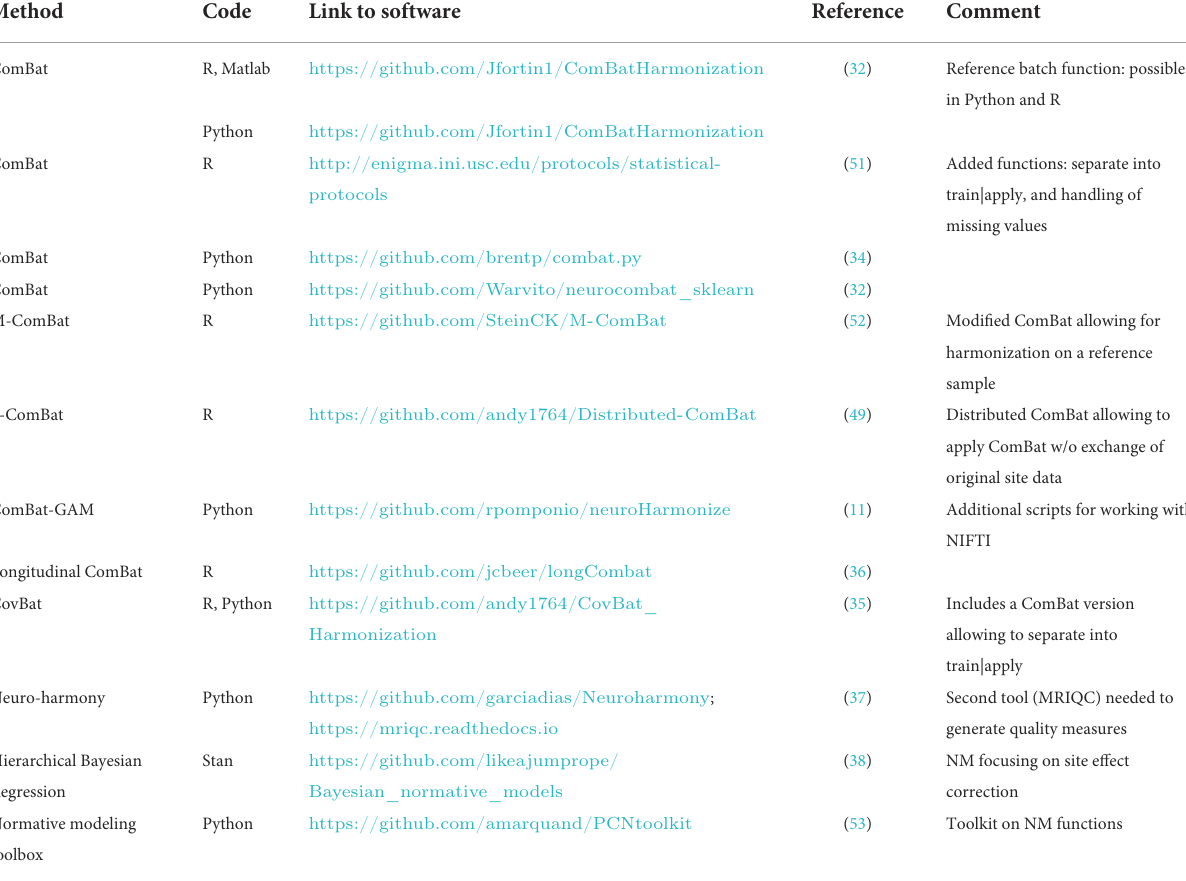
TABLE 1 List of tools and respective open source code